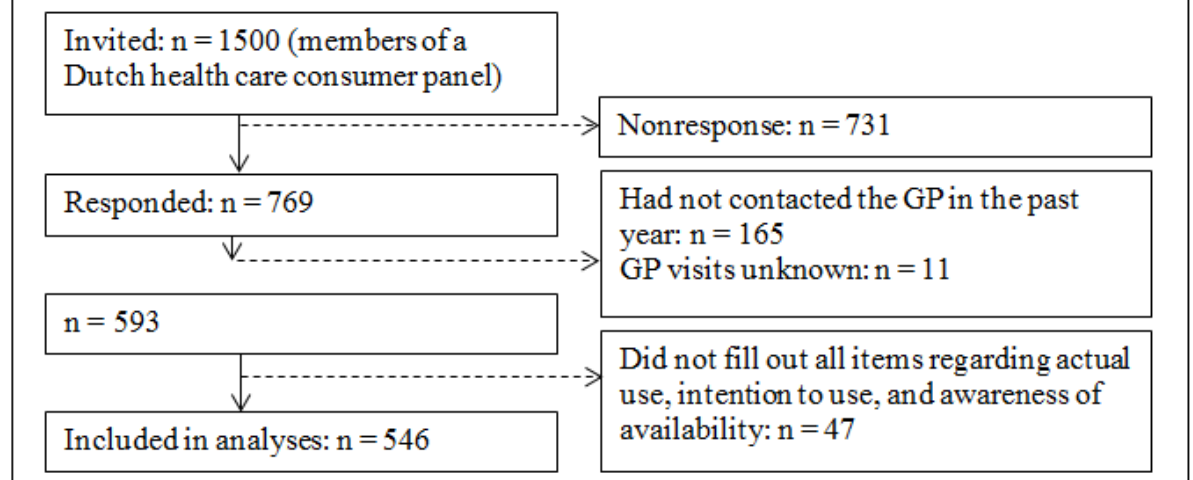
Figure 1. Flowchart of participants included in the study. GP: general